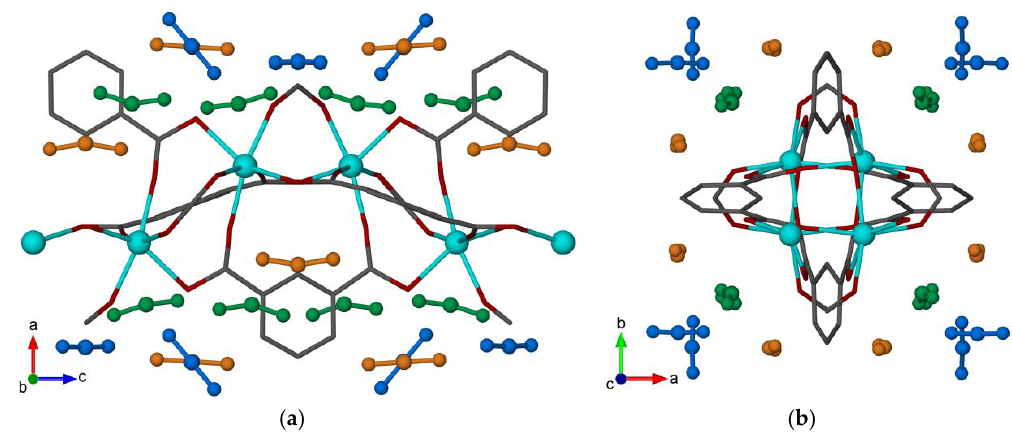
Figure 3. Depiction of all symmetry-generated CO 2 adsorption sites within the Y(btc) unit cell as determined by Rietveld refinement. Adsorption locations are viewed along the ( a ) b axis and ( b ) c axis. Shown are Site A CO2 (green), Site B CO2 (orange), Site C CO2 (blue), and framework atoms Y (light blue), C (dark grey), and O (red). Framework H atoms are omitted for clarity.